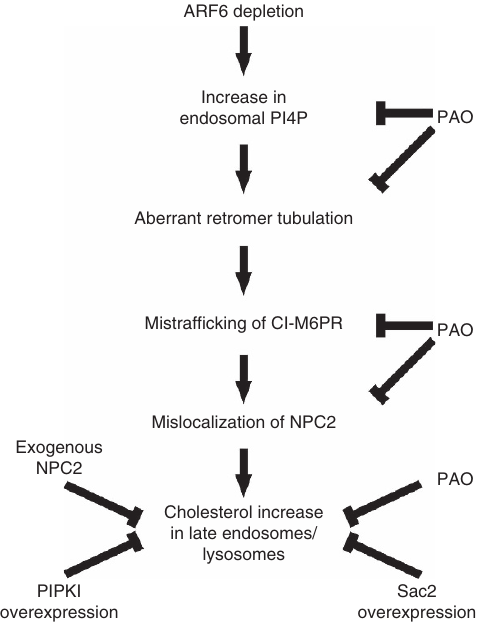
Figure 8 | Model of Arf6 regulation of cholesterol homeostasis. Arf6 controls an endosomal pool of PI4P and regulates retromer tubules dynamics in the endosome-to-TGN pathway, consequently impacting CI-M6PR and NPC2 localization (see also text). PAO: PI4K